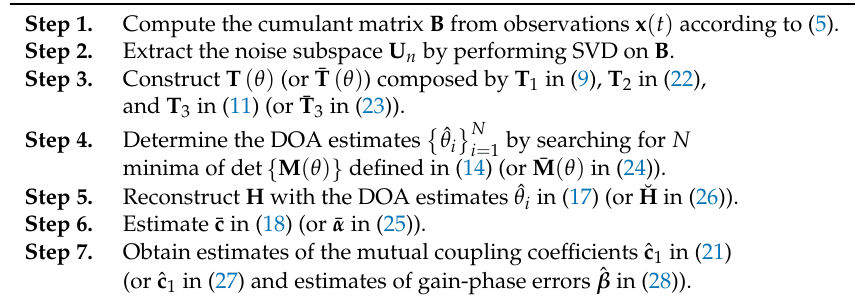
Table 1. Summary of the proposed method against the perturbations of nested